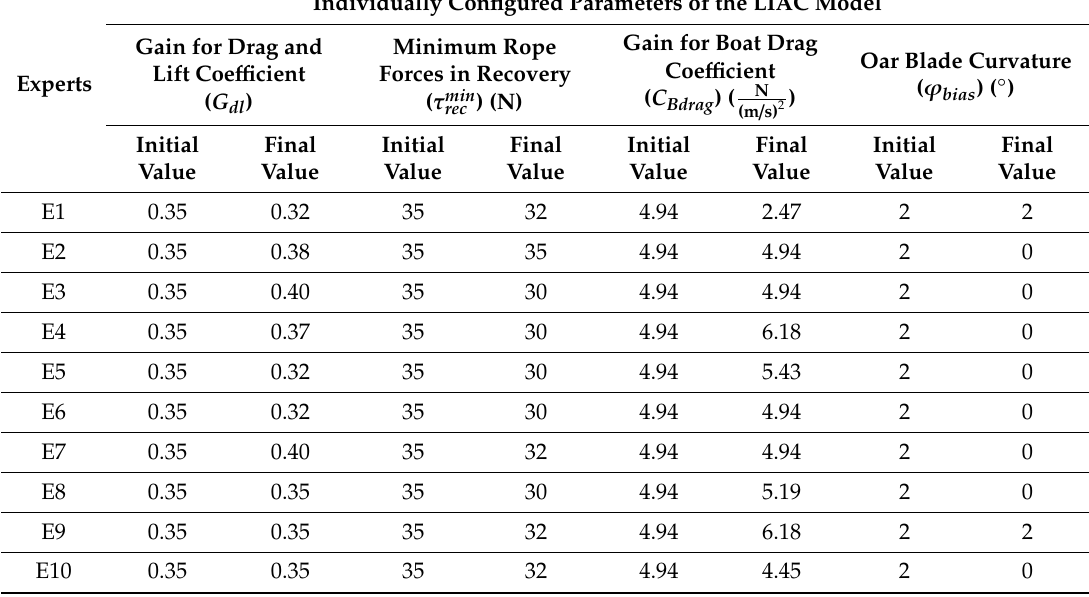
Table 1. Pre- and post-individualization values of the LIAC model parameters in Training